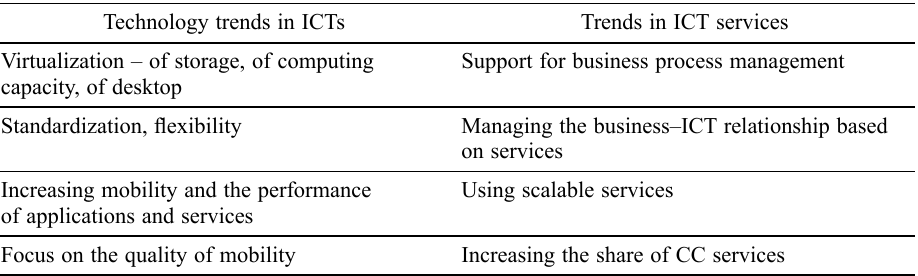
Table 2. Trends in ICTs and ICTs